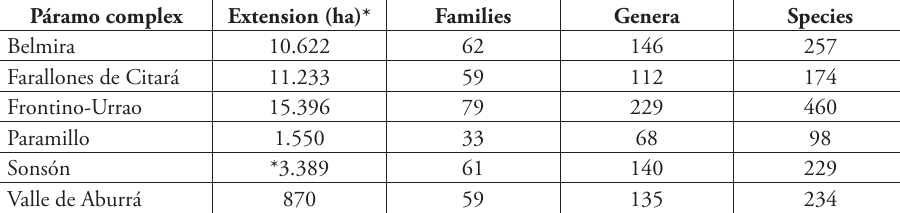
Table 1. Inventory of Angiosperms for each of the six páramo complexes of Antioquia. Páramo complex Extension (ha)* Families Genera Species Belmira 10.622 62 146 257 Farallones de Citará 11.233 59 112 174 Frontino-Urrao 15.396 79 229 460 Paramillo 1.550 33 68 98 Sonsón *3.389 61 140 229 Valle de Aburrá 870 59 135 234 *Area within the Department of